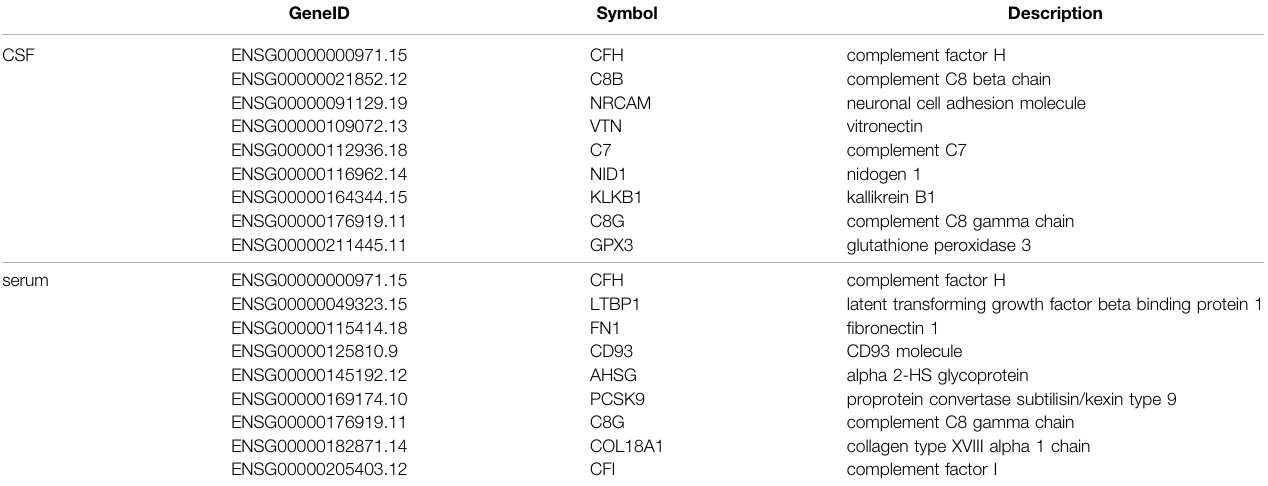
TABLE 3 | Genetic mutations identical to the CSF and serum differential protein. (Fold change = 1.2). GeneID